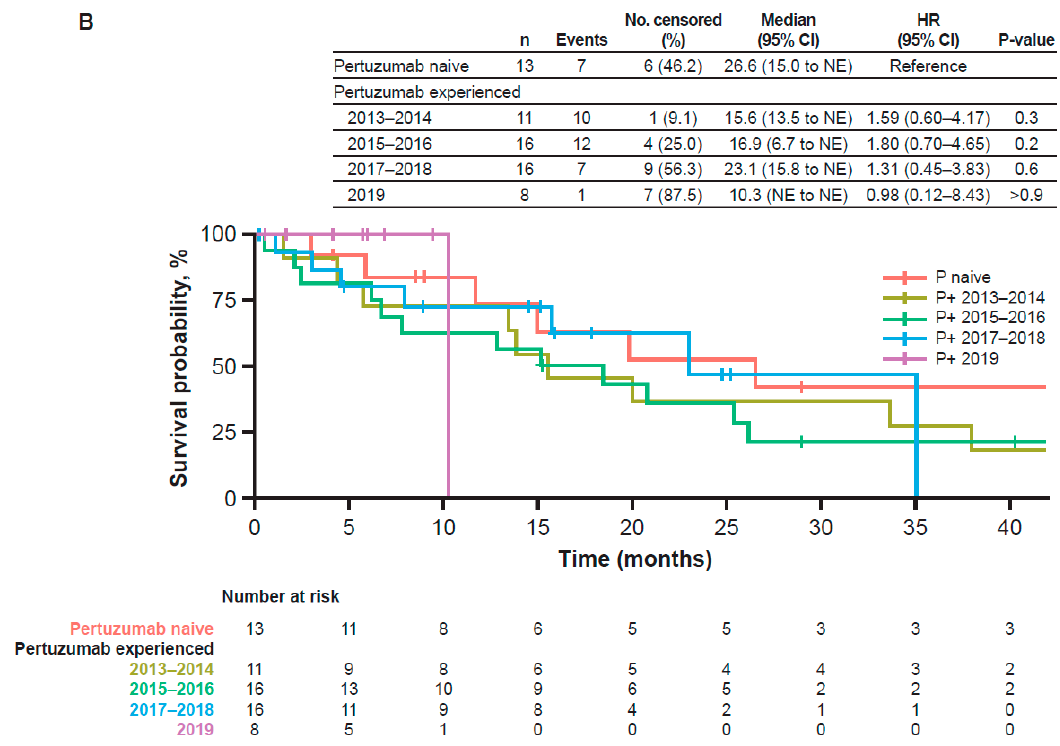
Figure A5. Effectiveness of 2L lapatinib following a 1L trastuzumab-containing regimen. ( A ) TTNT or death; ( B ) OS. 1L = first-line; 2L = second-line; CI = confidence interval; NE = not estimable; No = number; OS = overall survival; P = pertuzumab; P+ = pertuzumab-exposed; rwPFS = real-world progression-free survival; TTNT = time to next relevant treatment.